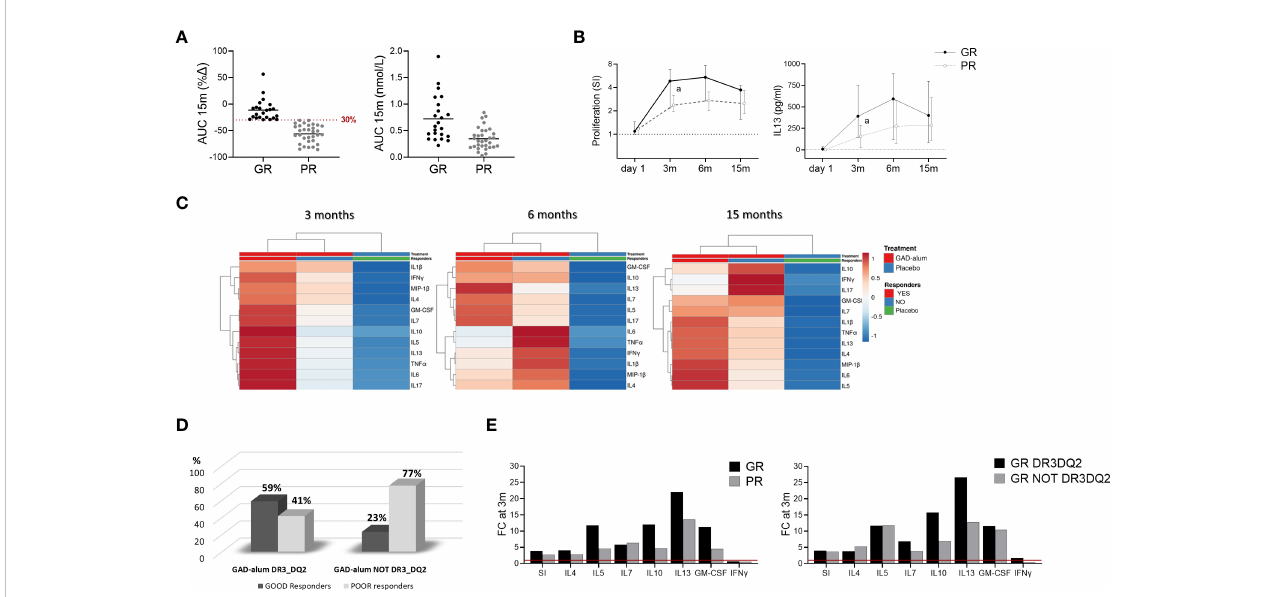
FIGURE 3 Immune responses in GAD-alum treated patients in relation to Clinical outcome. Patients who received GAD-alum were strati fi ed into Good Responders (GR, n=23, loss < 30% AUC) and Poor Responders (PR, n=32, loss ≥ 30% AUC) according to their C-peptide preservation at 15 months. (A) Percentage change of stimulated C-peptide (AUC) from day 1 to 15 months and s timulated C-peptide (AUC) nmol/L at 15 months in GR (black) and PR (grey). (B) Median values of PBMCs proliferative response and IL13 secretion to GAD 65 (5 µg/ml) in GR (black) and PR (grey) patients. Proliferation is expressed as stimulation index (SI), calculated from the mean of triplicates in the presence of GAD 65 divided by the mean of triplicates with medium alone. Median levels of IL13 are given after subtraction of spontaneous secretion from each individual and expressed as pg/ml (C) Heatmap of GAD 65- induced cytokine secretion (5 µg/ml) in GR and PR receiving GAD-alum, and the placebo group. Columns with similar annotations (Treatment and Responders) were collapsed by taking median inside each group. Heatmap was performed using Clustvis software. Heatmap data matrix visualizes the values in the cells using a color gradient which gives an overview of the largest and smallest values in the matrix (D) Percentage of GR (black) and PR (grey) individuals in the GAD-alum treated patients with DR3DQ2 (GR: n=17; PR: n=12) or without DR3DQ2 (GR: n=6; PR: n=21). (E) Fold change of cytokine secretion and proliferation at 3 months, detected in PBMCs supernatants after 7-days culture in presence of GAD 65 (5 µg/ml). GAD 65 -induced IL4, IL5, IL7, IL10, IL13, IFN g and GM-CSF secretion and Proliferation (SI) at 3 months is expressed as fold change from day 1 (red line), between GR (black) and PR (grey) in GAD- alum treated patients and in GR group with (black) and without (grey) DR3DQ2 haplotype. Error bars indicate 95% CI. Differences between groups were calculated using Mann-Whitney unpaired test. a: